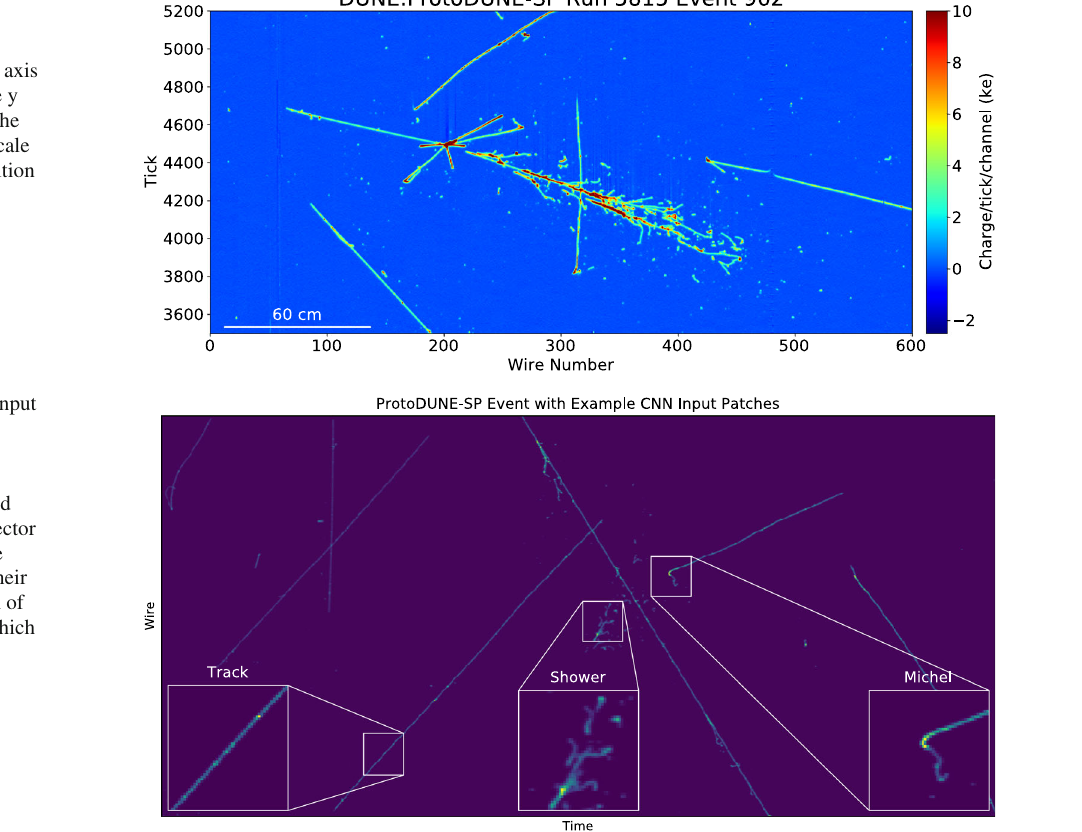
Fig. 1 A 7GeV/ c beam π + interaction in the collection view (W-view) in ProtoDUNE-SP data. The x axis shows the wire number. The y axis shows the time tick in the unit of 0.5 µ s. The colour scale represents the charge deposition